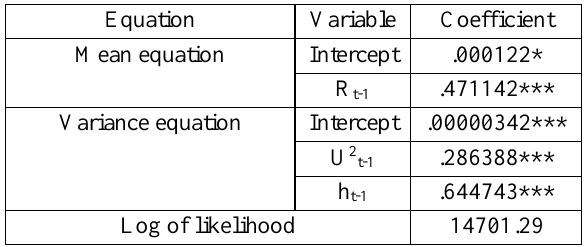
Table 2: results of estimating single-regime GARCH model Equation